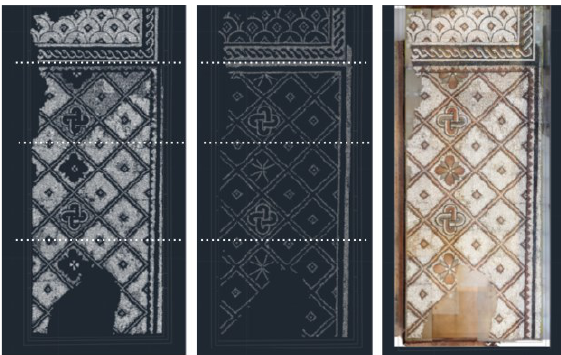
Figure 17. Semi-automatic vectorization process of white, black, and polychrome tiles, compared with ortho-image of mosaic